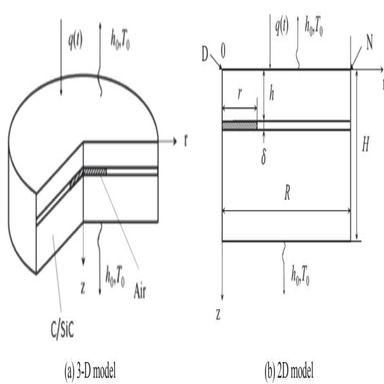
Numerical simulation models.